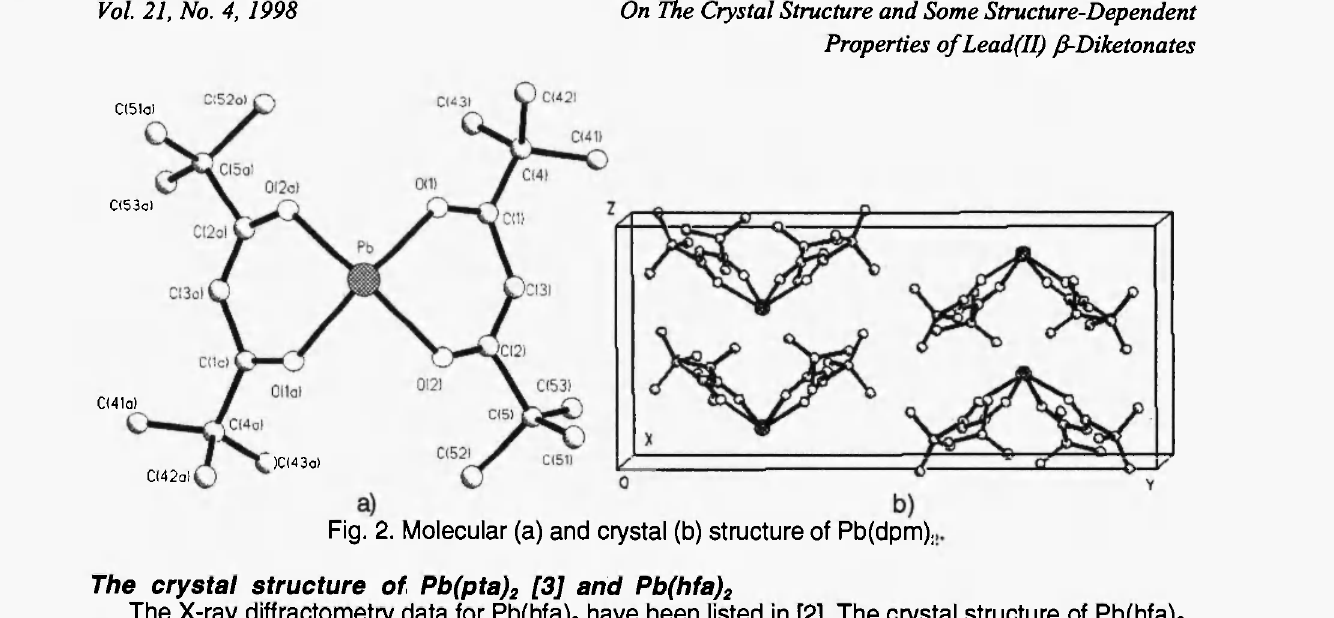
Fig. 2. Molecular (a) and crystal (b) structure of